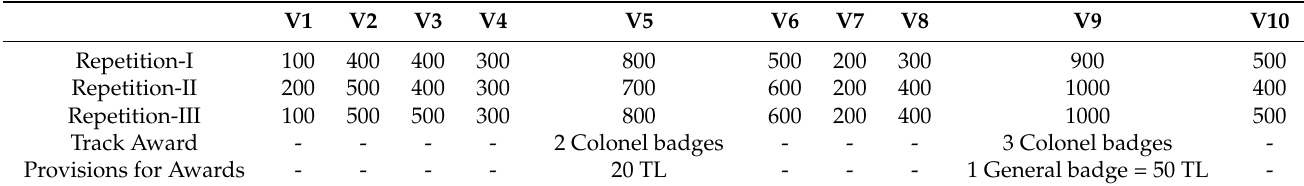
Table 5. Participants game points and rewards chart.